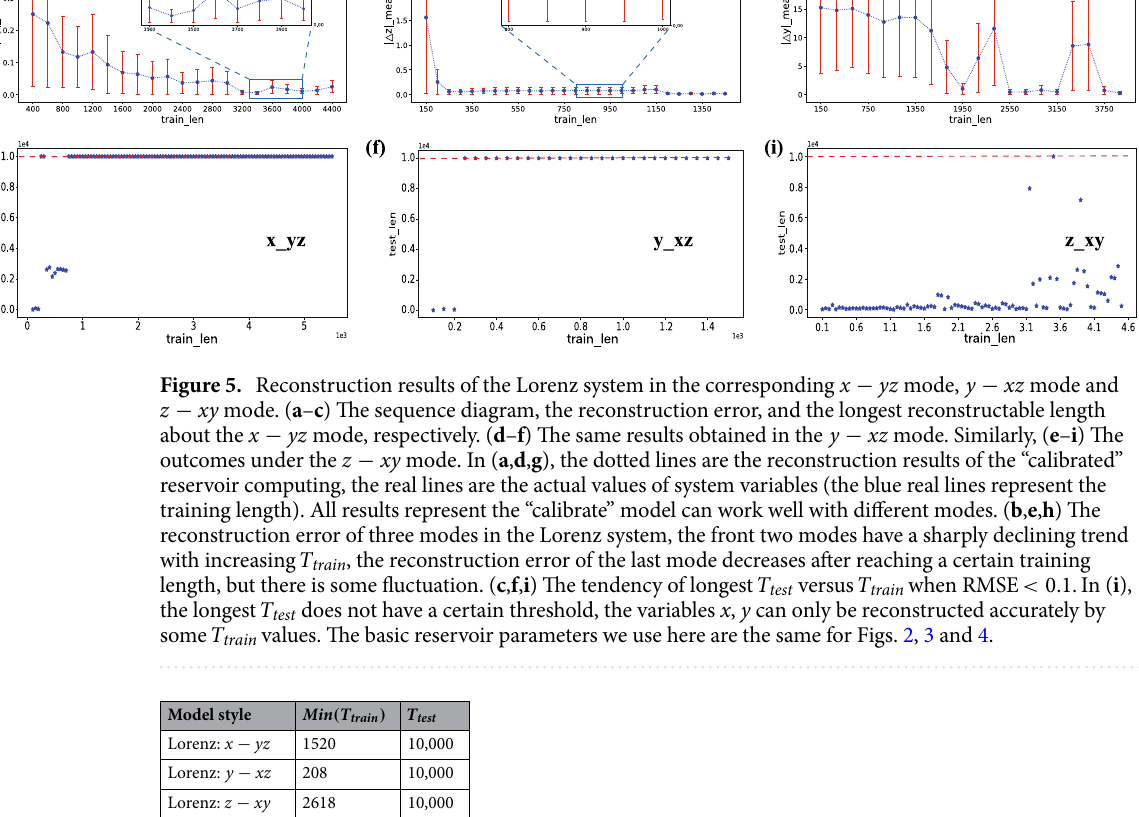
Table 2. Shortest training length of the Lorenz system in the case 2( T test = 10 4 , RMSE < 0.1 ).